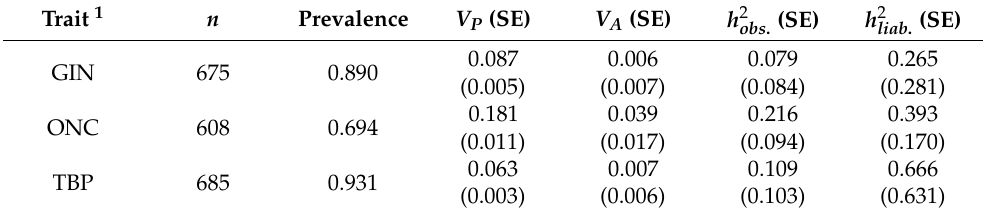
Table 2. Population specific parameters of the investigated traits. The estimated phenotypic (V P ) and additive genetic (V A ) variance, the heritability estimated on the observed ( h 2 scale ( h 2 ) as well as their standard errors (in parentheses) are shown. The number of evaluated liab . individuals ( n ) and the observed prevalence in the investigated population are